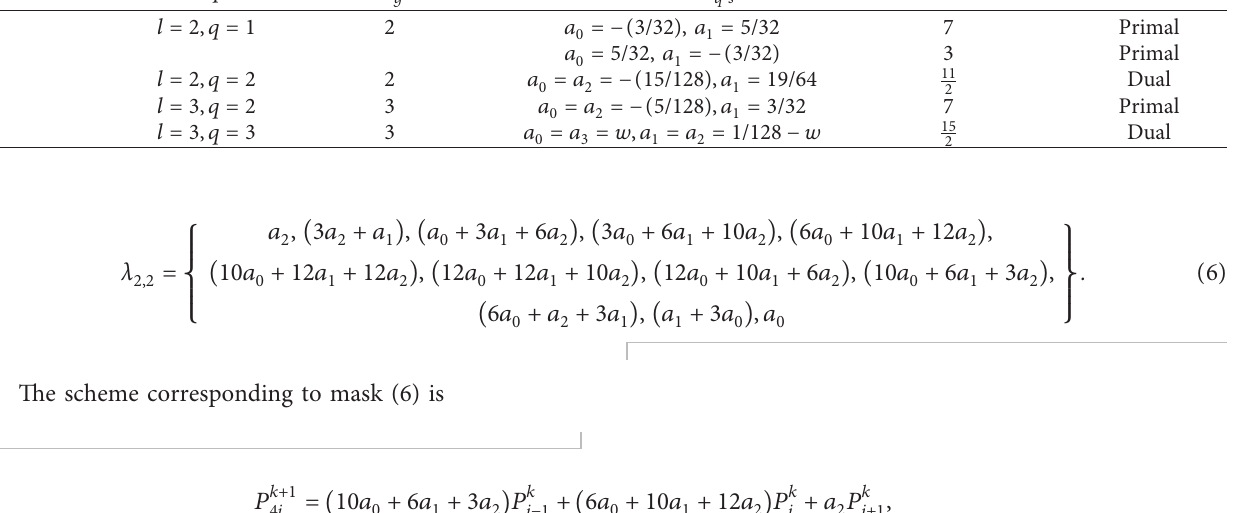
Table 2: The degree of generation of family of unified quaternary curve subdivision scheme for different cases.